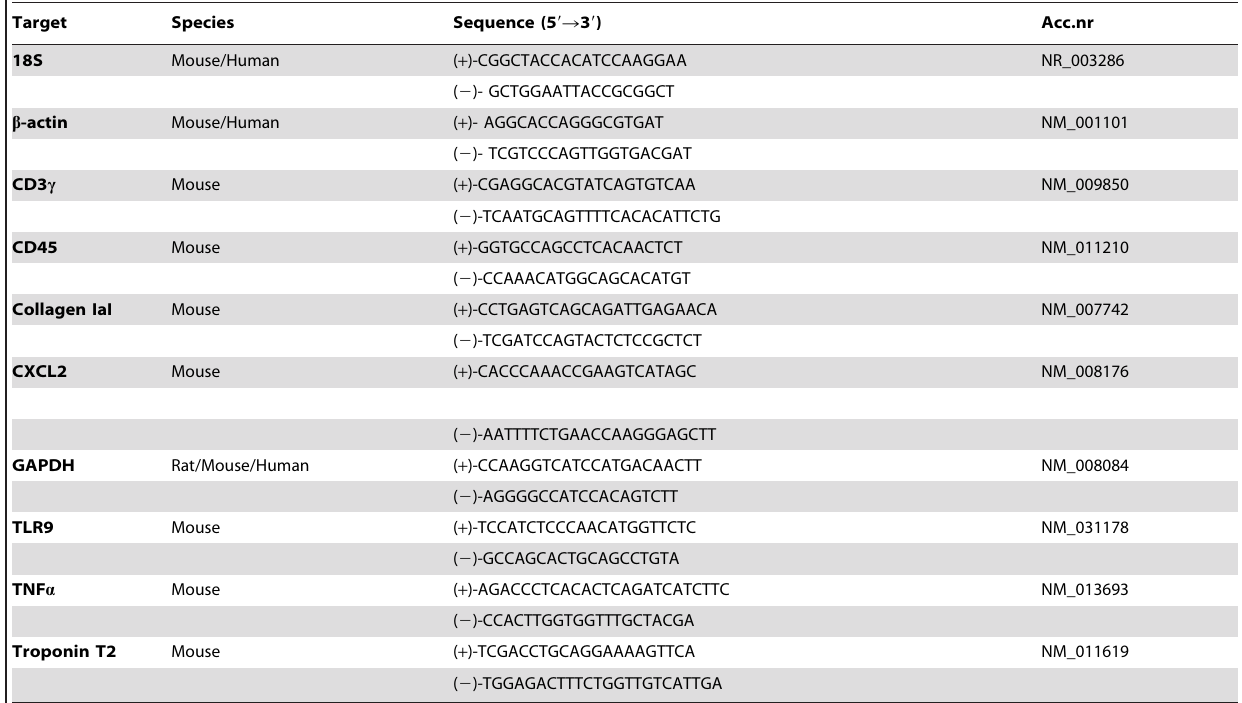
Table 1. Primer sequences used in qPCR